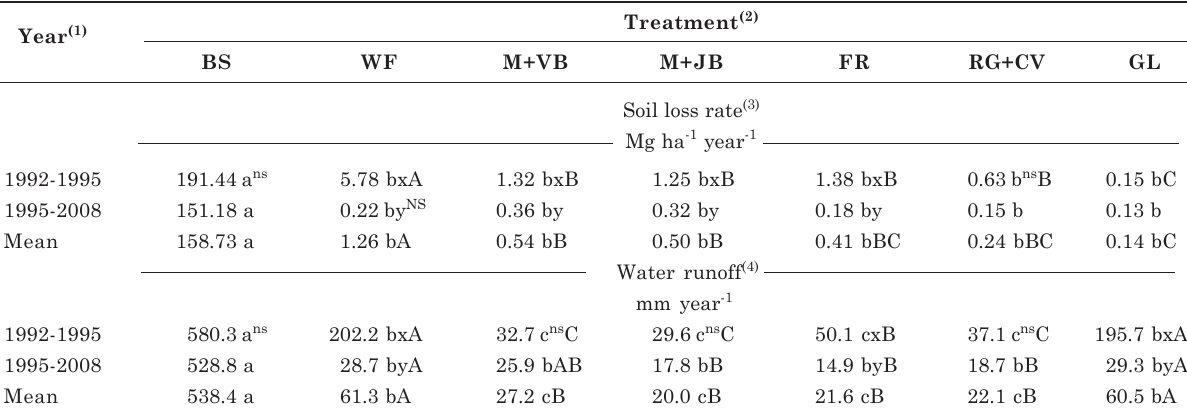
Table 3. Mean soil loss rate and water runoff in different periods in a long-term experiment, comparing bare soil, grassland and no-tillage cropping systems